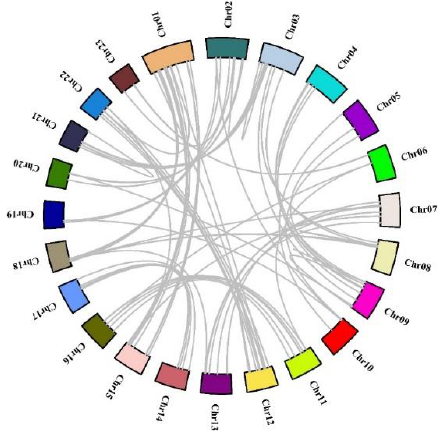
Figure 2. Schematic representations of the interchromosomal relationships of the 2R-MYB genes. Gray lines suggest duplicated MYB gene pairs in the sweet osmanthus genome.